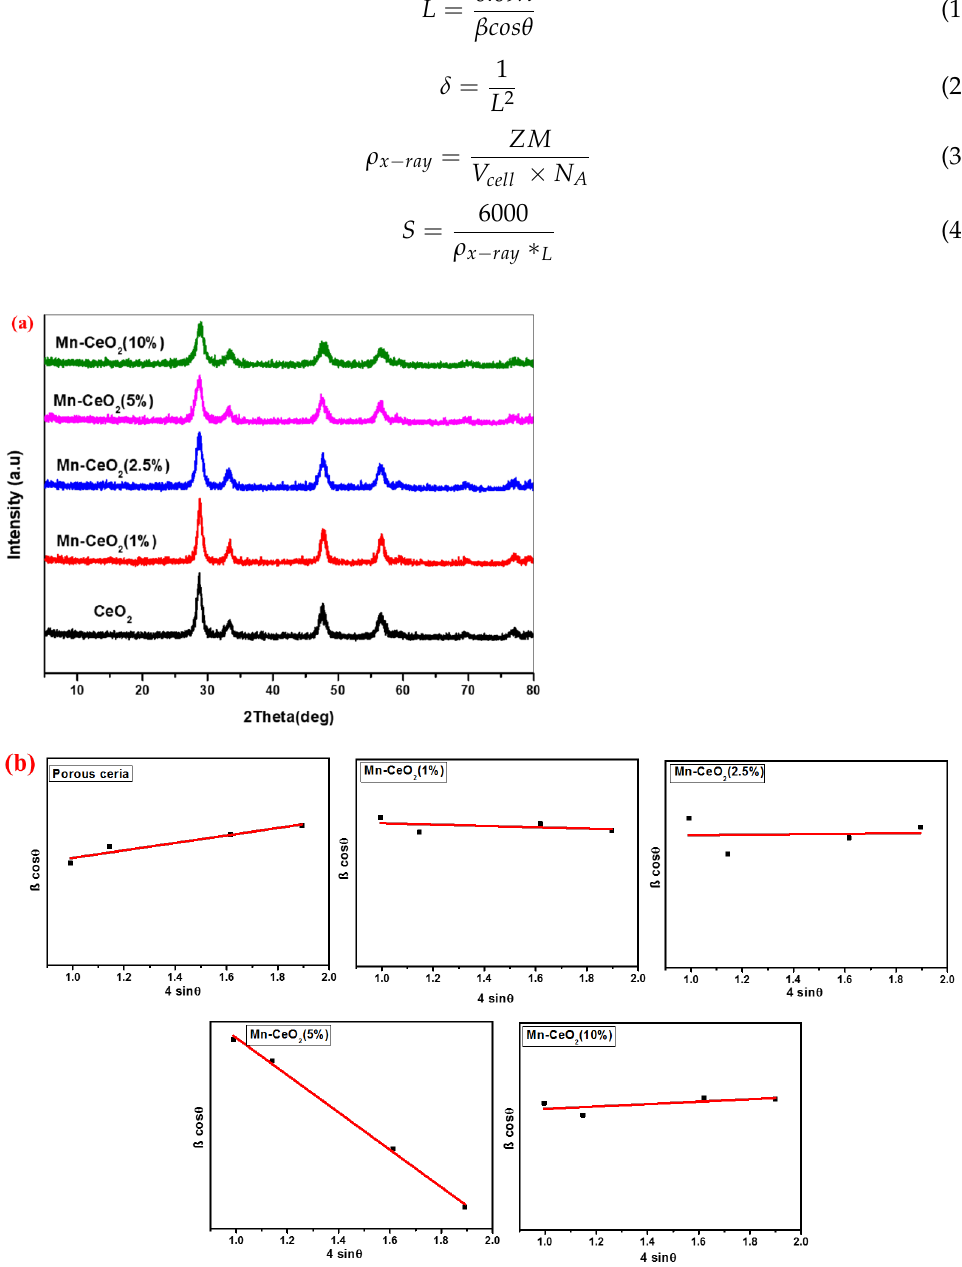
Figure 1. ( a ) XRD patterns. ( b ) W – H plots of the prepared porous ceria with and without Mn doping. Table 2. Lattice constants were obtained theoretically for all Mn-CeO 2 samples.